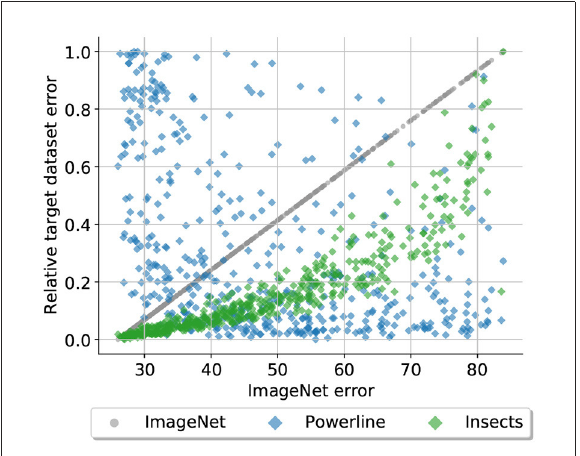
FIGURE1 Is a CNN architecture that performs well on ImageNet automatically a good choice for a different vision dataset? This plot suggests otherwise: It displays the relative test errors of 500 randomly sampled CNN architectures on three datasets (ImageNet, Powerline, and Insects) plotted against the test error of the same architectures on ImageNet. The architectures have been trained from scratch on all three datasets. Architectures with low errors on ImageNet also perform well on Insects, on Powerline the opposite is the